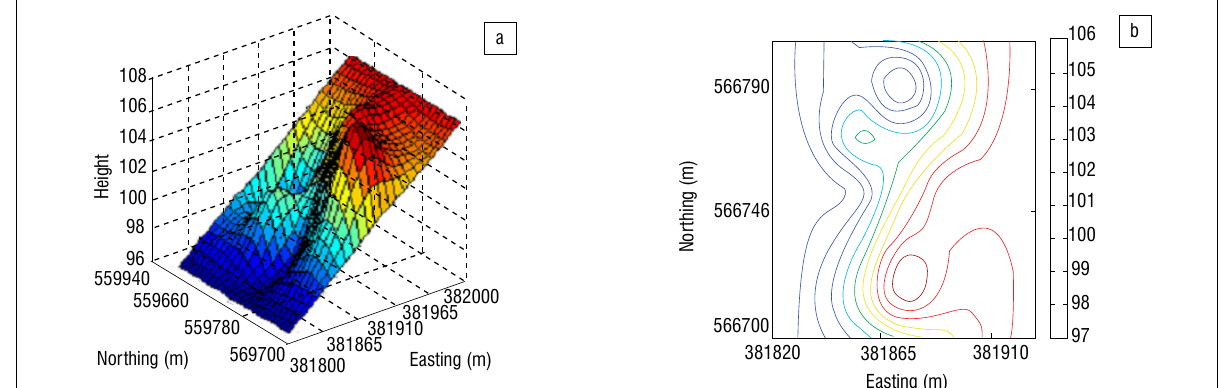
Figure 6: Support vector machine regression method (a) digital terrain model plot and (b) contour